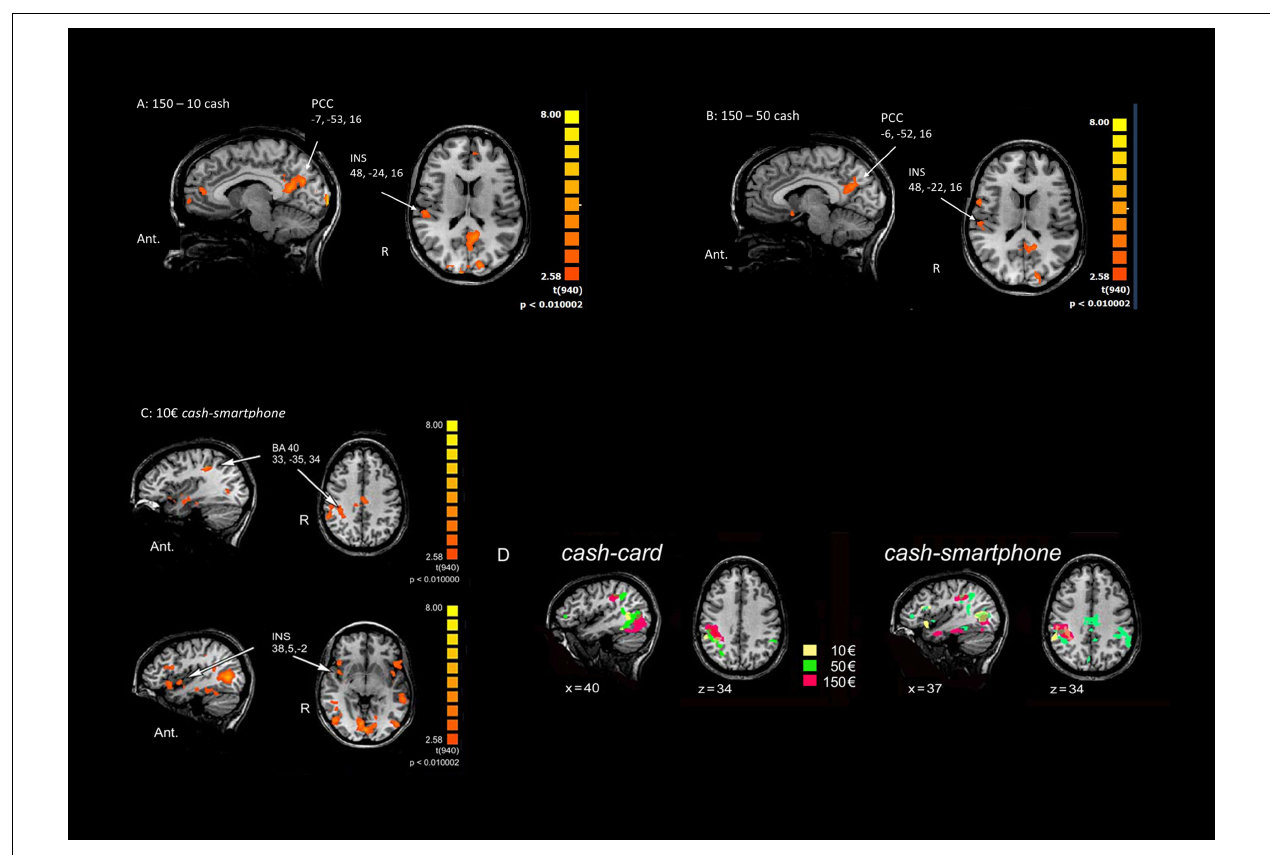
FIGURE 2 | Main effects of contrasting methods of payment and payment amounts. (A) 150€ vs. 10€ in the Cash condition. (B) 150€ vs 50€ in the Cash condition. (C) Cash vs Smartphone contrast in the 10€ condition. The Talairach coordinates refer to the activated foci pointed by arrows. Ant.: anterior; R: right. (D) Cortical activation in the right parietal cortex in Cash vs Card (left) and the Cash vs Smartphone (right) contrasts in the three conditions (10€: yellow; 50€: green; 150€: